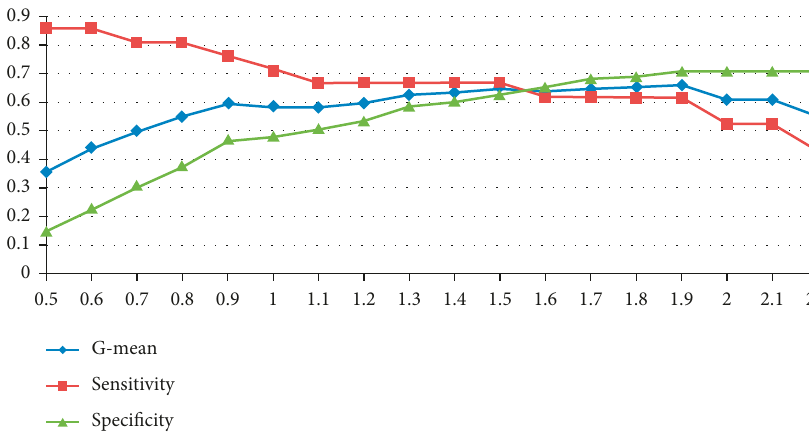
Figure 15: Performance values of SWAB on BAC with different merging